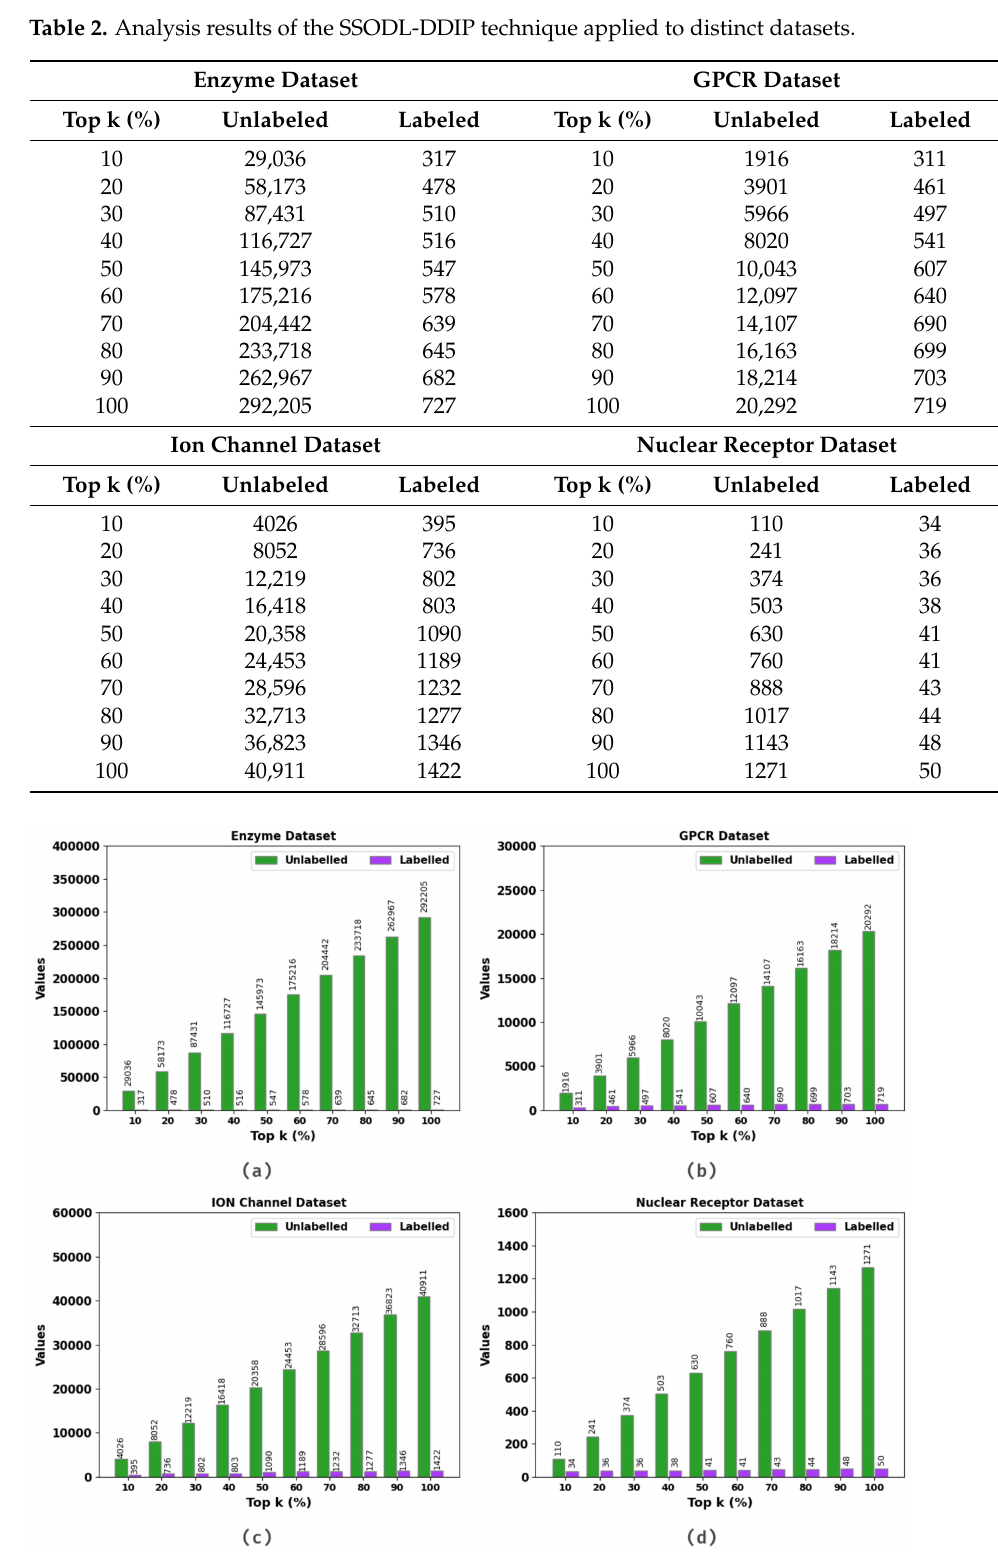
Figure 4. Result analysis of the SSODL-DDIP system: ( a ) Enzyme; ( b ) GPCR; ( c ) ion channel; ( d ) nuclear